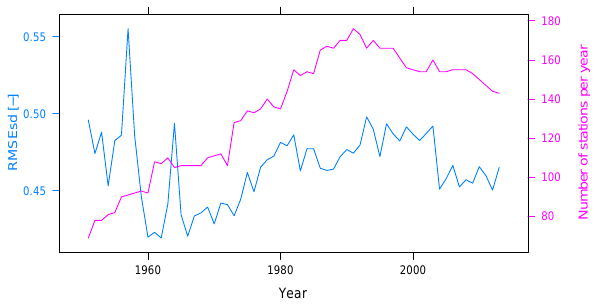
Figure 11. Annual RMSEsd median (blue) and number of avail- able stations per year (pink) for maximum temperature in the period 1951–2013. The daily results, also summarized in Table 1, were used for calculating the annual medians.